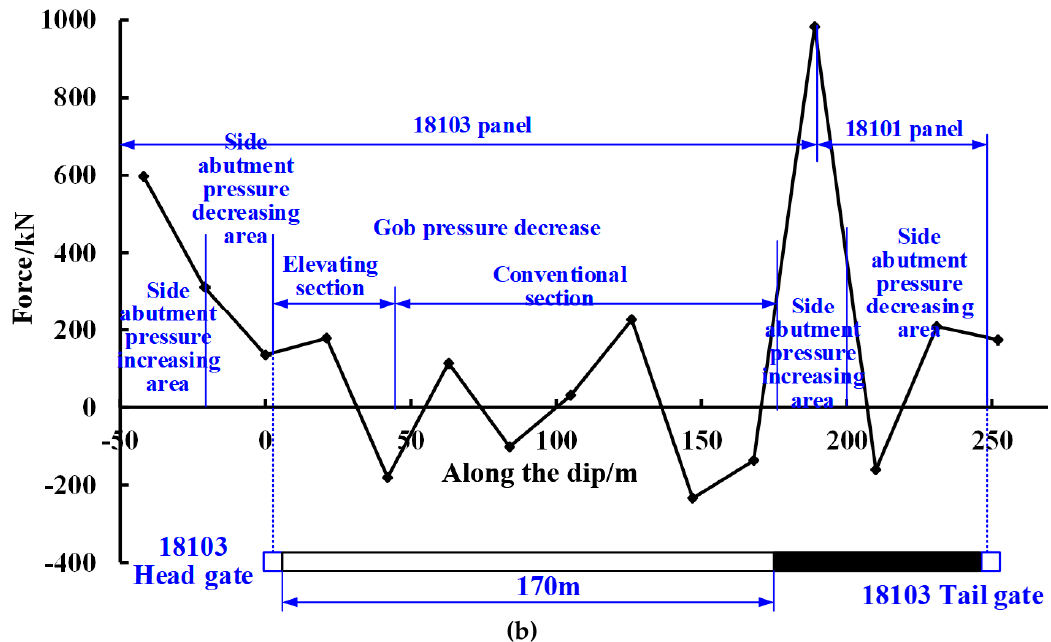
Figure 14. Pressure distribution for different extraction lengths of the panel. ( a ) Pressure distribution when 90 m of the panel is extracted; ( b ) Pressure distribution when 170 m of the panel is extracted.